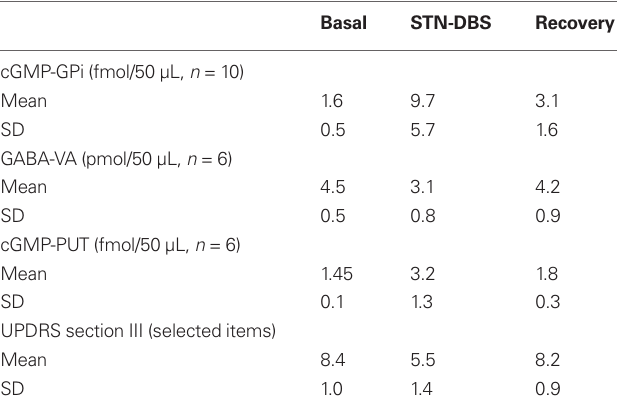
Table 1 | The table synthesizes the more relevant data detected by microdialysis samples during efficacious